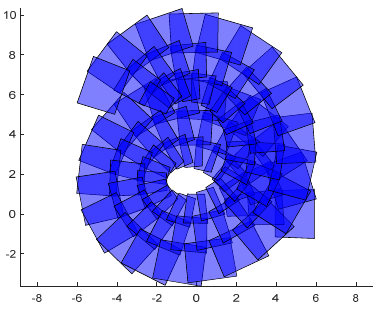
Figure 27. Simulation of ground experiment coverage in the OCPSI mode.